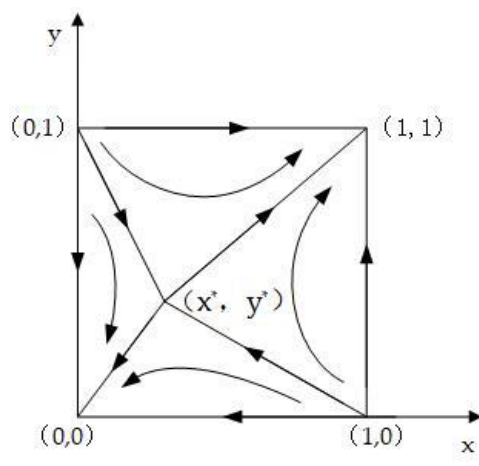
Figure 2. Phase diagram of the evolutionary game.